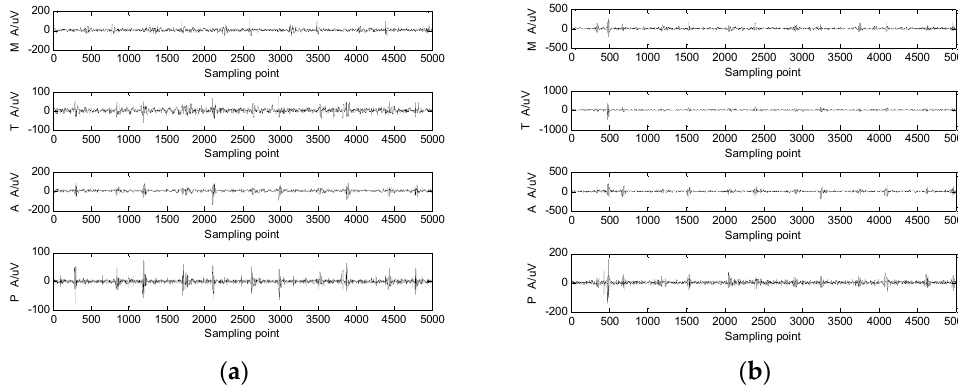
Figure 3. The 4-channel heart-sound signal in 2 states: ( a ) resting state—Step 1A; ( b ) state of motion—Step 2A.